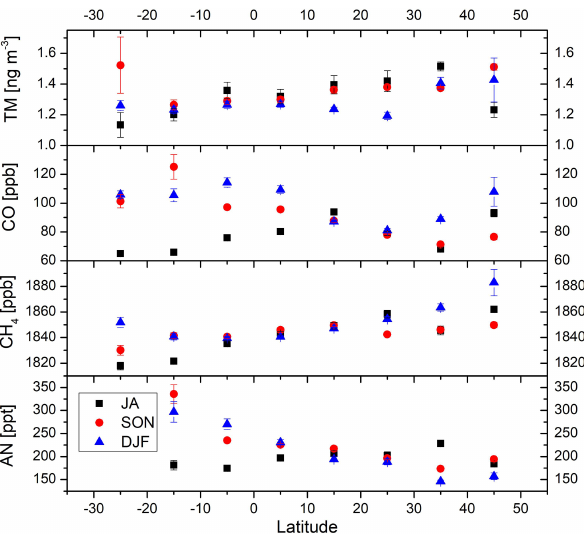
Figure 2. Latitudinal distributions of tropospheric (PV ≤ 1.5PVU) TM, CO, CH 4 and acetonitrile (AN) during the flights from Bo- gota and São Paulo and Rio de Janeiro to Munich in summer (only July and August, JA), autumn (September, October and Novem- ber, SON) and winter (December, January and February, DJF). The points represent averages and the vertical bars their standard error. No acetonitrile data were available south of 20 ◦